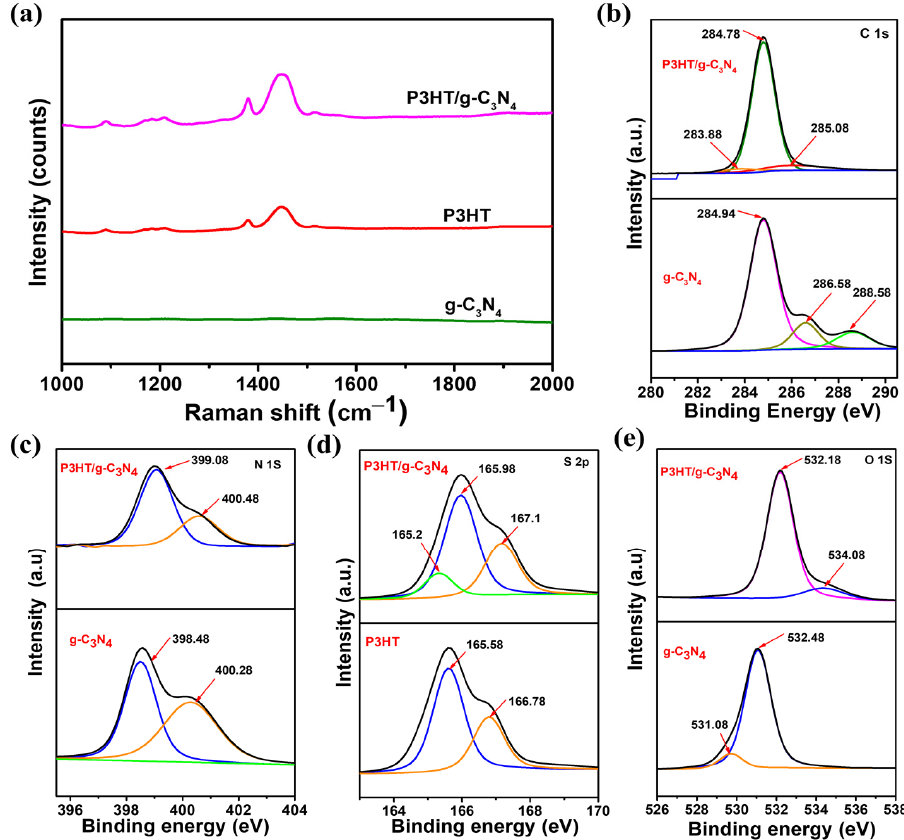
Figure 5. ( a ) Raman spectra of g-C ₃ N ₄ , P3HT, and P3HT/g-C ₃ N ₄ composite films. XPS survey spectra of ( b ) C 1s for g-C ₃ N ₄ and P3HT/g-C ₃ N ₄ , ( c ) N 1s for g-C ₃ N ₄ and P3HT/g-C ₃ N ₄ , ( d ) S 2p for P3HT spectra of ( b ) C 1s for g-C 3 N 4 and P3HT/g-C 3 N 4 , ( c ) N 1s for g-C 3 N 4 and P3HT/g-C 3 N 4 , ( d ) S 2p and P3HT/g-C ₃ N ₄ , and ( e ) O 1s for g-C ₃ N ₄ and P3HT/g-C ₃ N ₄ . for P3HT and P3HT/g-C 3 N 4 , and ( e ) O 1s for g-C 3 N 4 and P3HT/g-C 3 N 4